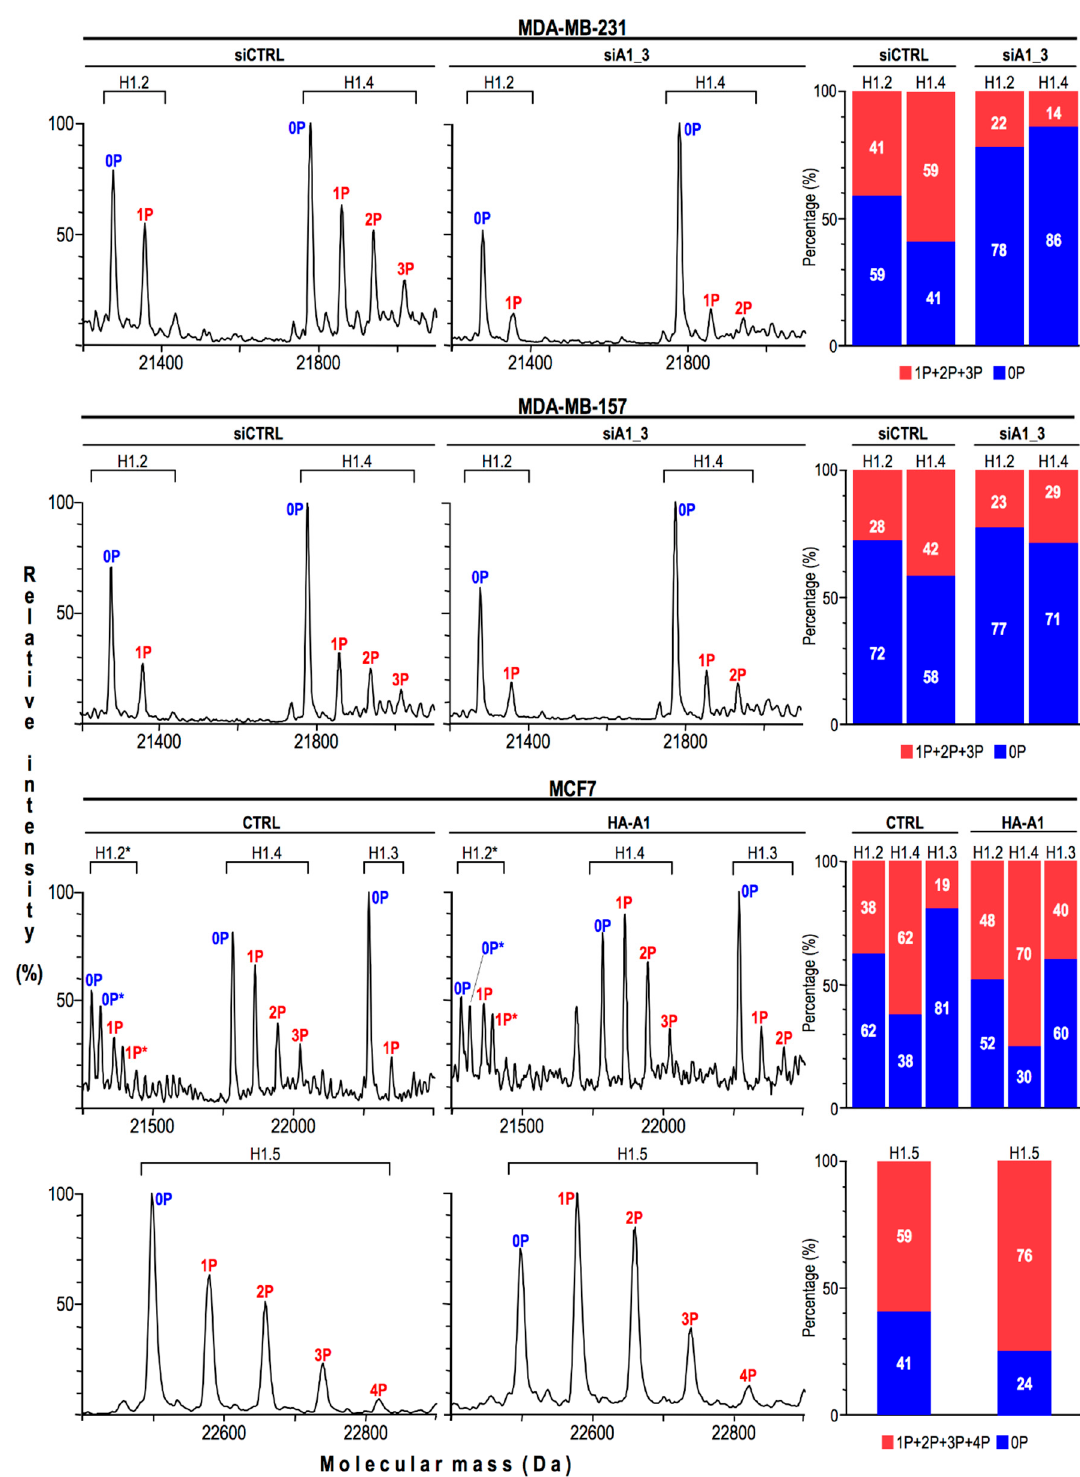
Figure 4. Histone H1 phosphorylation is linked to HMGA1 expression level. Left part: Reconstructed mass spectra of histone H1 variants obtained from MDA-MB-231 and MDA-MB-157 cells treated with siCTRL and siA1_3 and from control (CTRL) and HA-HMGA1 overexpressing (HA-A1) MCF7 cells. The various histone H1 variants are indicated above each spectrum. 0P, 1P, 2P, 3P, and 4P indicate the number of phosphate groups. *: MCF-7 cells express two histone H1.2 allelic variants. Right part: Histogram graphs showing for each histone H1 variant the distribution in terms of percentage between unphosphorylated (0P) and phosphorylated forms (1P + 2P + 3P + 4P). The percentage values are indicated within each bar.